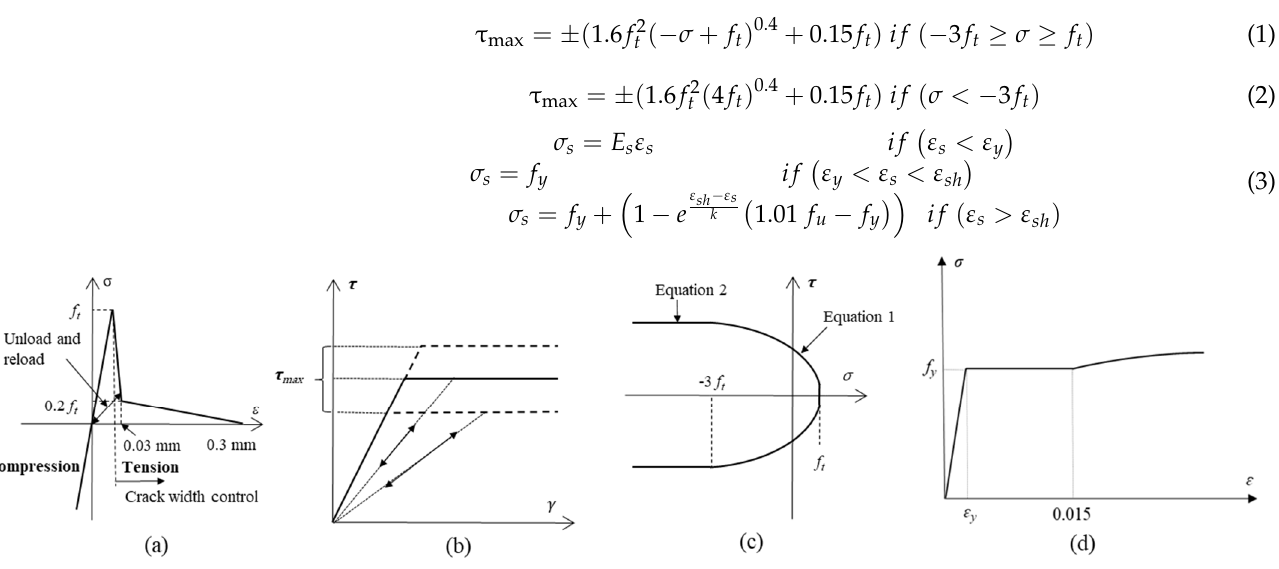
Figure 3. Constitutive laws governing the behavior of ( a ) normal springs in concrete ( b ) elasto-plas- tic behavior for shear spring in concrete ( c ) calculation of maximum shear stress for shear springs for concrete and ( d ) tensile behavior of reinforcing bar in 3D RBSM Reprinted with permission from [13]. 2021, Elsevier.